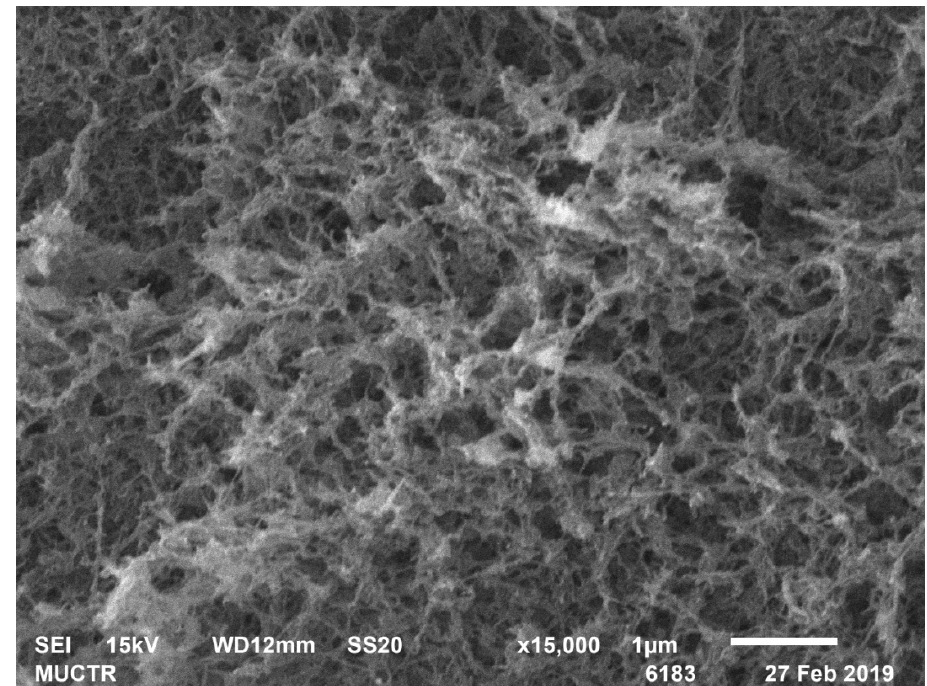
Figure 7. SEM-image of sample 8 chitosan-based aerogel particles.